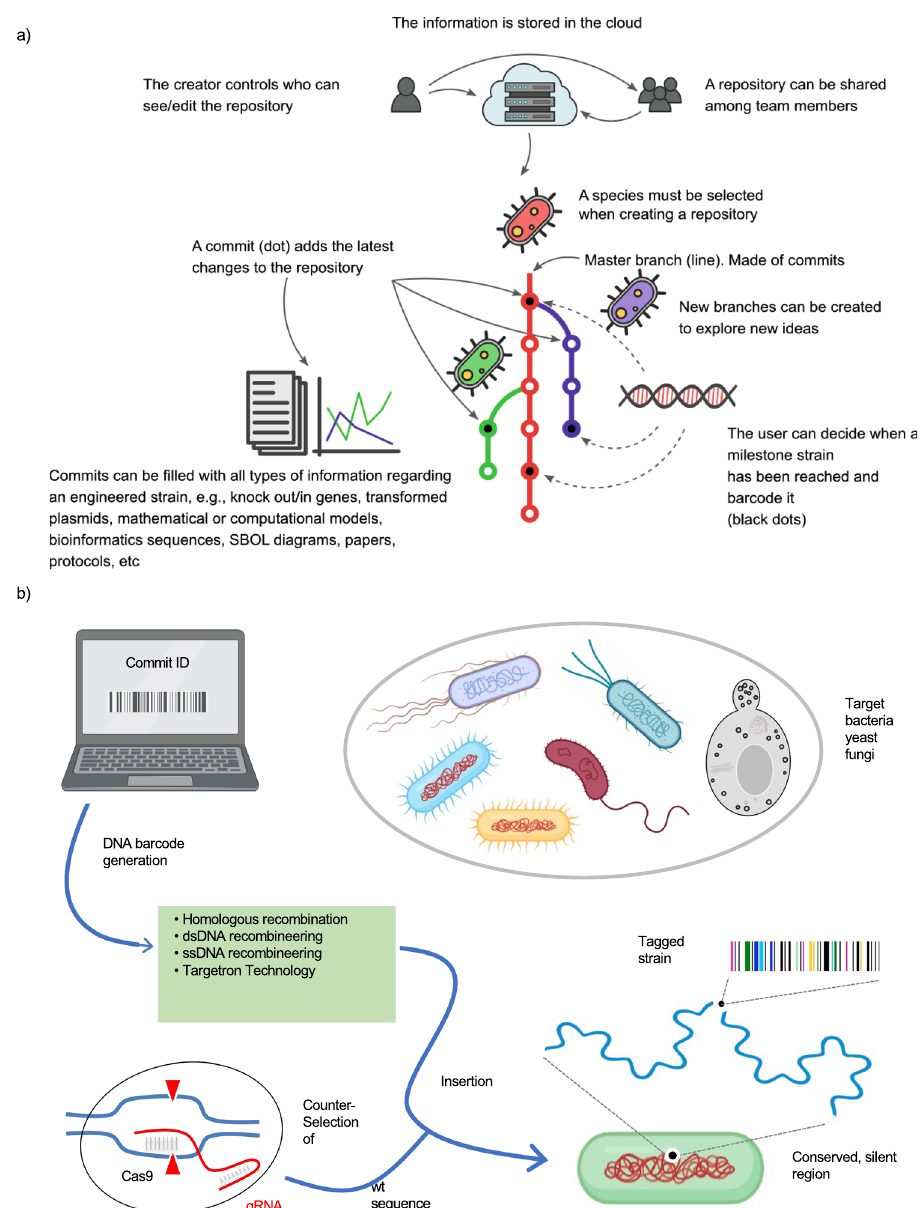
Fig. 1 Version control and barcoding of engineered cells. a Graphical description of CellRepo. A repository contains all the information of the project. Several ideas can be tested using the branching mechanism. The users can decide what to document at each stage in the project through commits. At user- de fi ned steps, a physical DNA barcode can be generated to be inserted in the genome of the strain. b Work fl ow for barcoding any microorganism or strain of interest. The roadmap can be applied to basically any biological system amenable to genomic insertions of short DNA sequences. Once a speci fi c barcode is committed, it is synthesized and delivered to a stable region of the genome of the target organism. The different approaches followed in this study to select appropriate barcoding locations are described in the Supplementary Material. This can be made with a whole collection of genetic tools available to this end in a fashion dependent or independent on homologous recombination. As the resulting insertion is expected not to generate a conspicuous phenotype, proper delivery of the barcode to the expected genomic site is secured and selected with CRISPR/Cas9 technology or via the more traditional antibiotic resistance or auxotrophic marker approach depending on the laboratory carrying out the